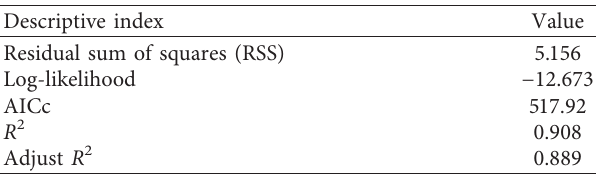
Table 4: Global regression results of MGWR